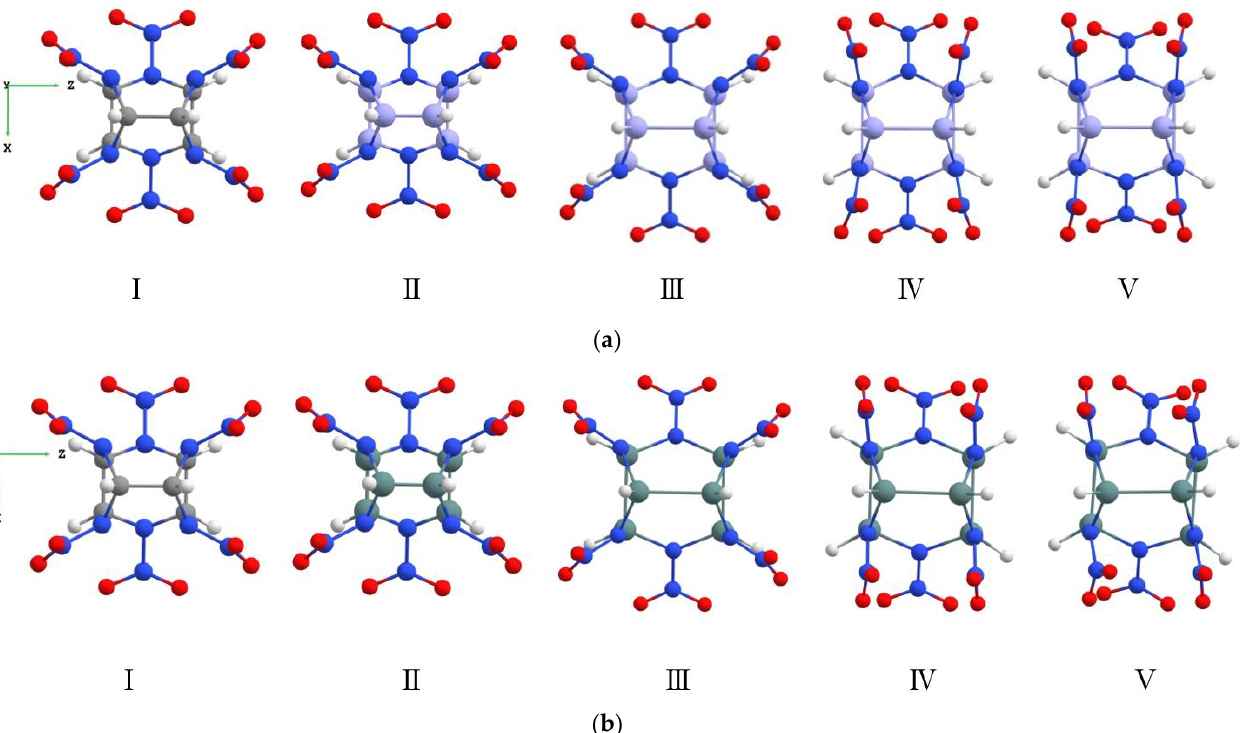
Figure 2. ( a ) From pure CL-20 to substituted Si 6 CL-20; ( b ) From pure CL-20 to substituted Ge 6 CL-20. I—The isolated molecule CL-20 (top view); II—the isolated non-optimized molecule Si 6 CL-20/Ge 6 CL- 20 (Si-/Ge-atoms replaced all C-atoms); III, IV—optimization steps of Si 6 CL-20/Ge 6 CL-20 (increase in diameter and rotation of functional groups NO 2 ); V—the isolated optimized molecule Si 6 CL- 20/Ge 6 CL-20. The color codes of the atoms are the same as in Figure 1.